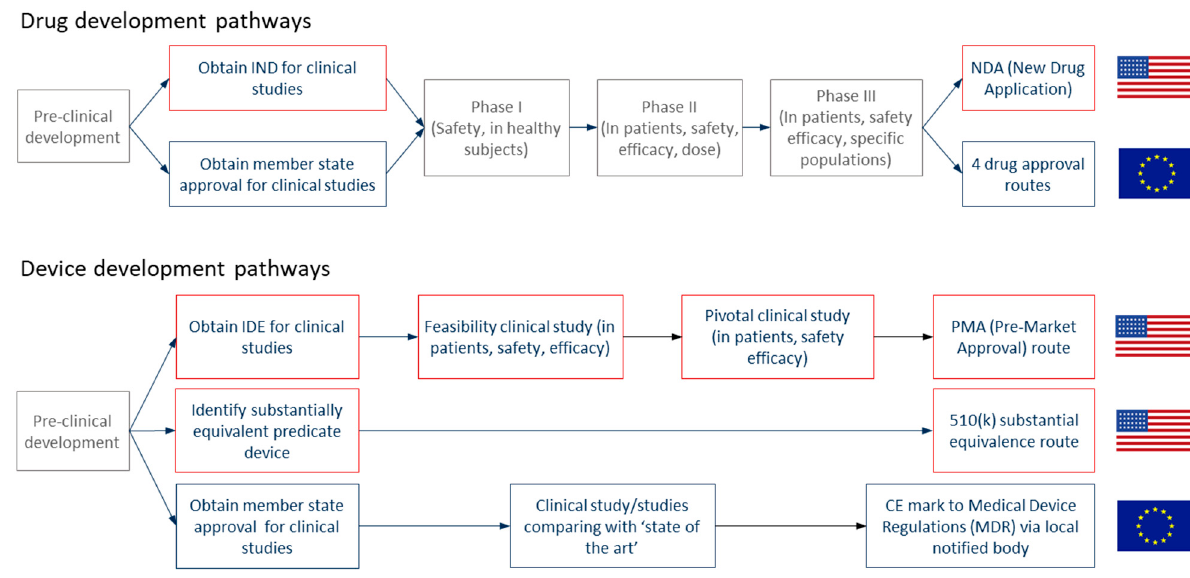
Figure 5. Development and regulatory pathways for drugs and devices in the US and Europe. IDE stands for Investigational Device Exemption, while IND stands for Investigational New Drug Application. Table 4. EU and US regulatory authority definitions of drug and medical device (emphasis